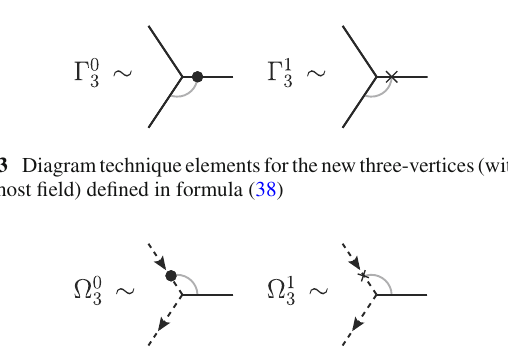
Fig. 4 Diagram technique elements for the new three-vertices (with the ghost field) defined in formula